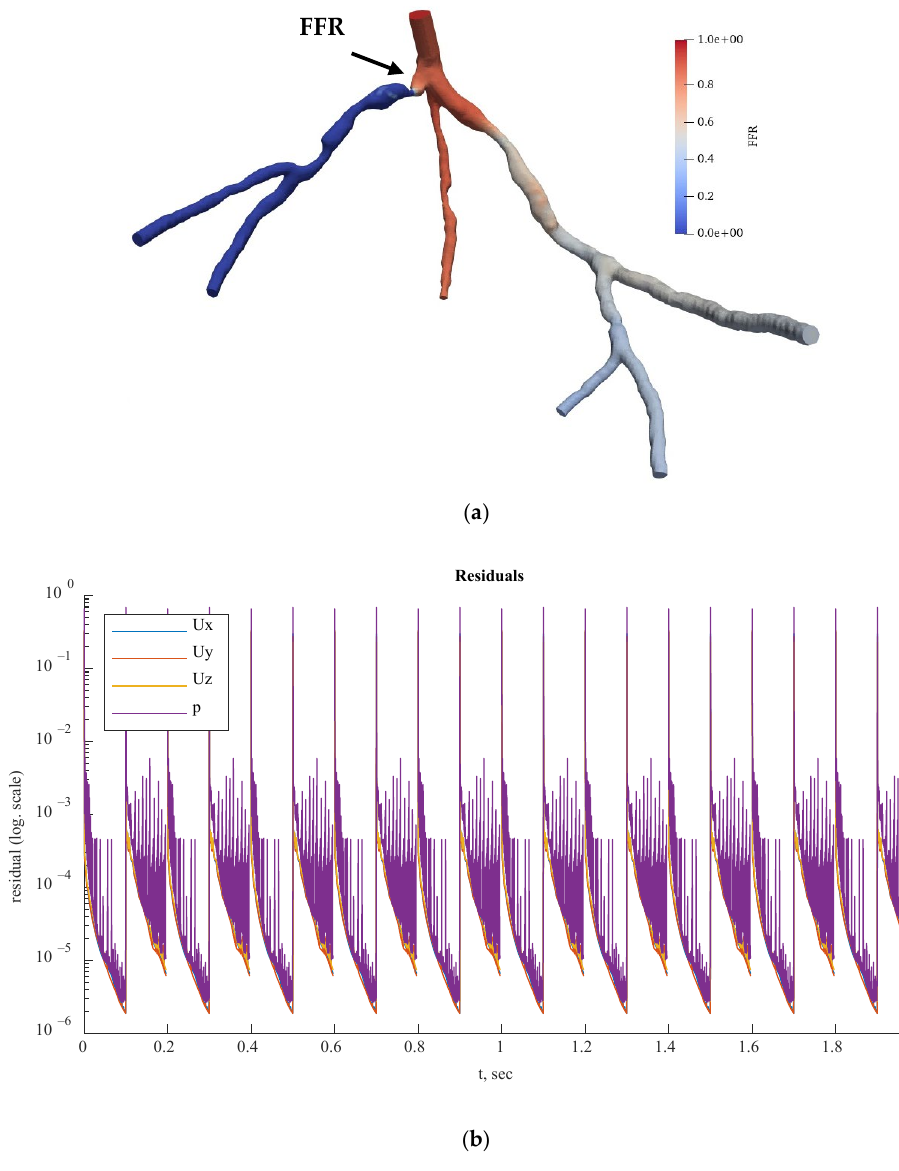
Figure 19. ( a ) FFR distribution with shape of CHN13 transient PBA model and ( b ) PBA residual history .